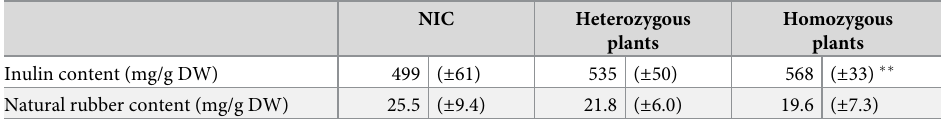
Table 3. Inulin and natural rubber content of TkRALFL1 knockout plants.